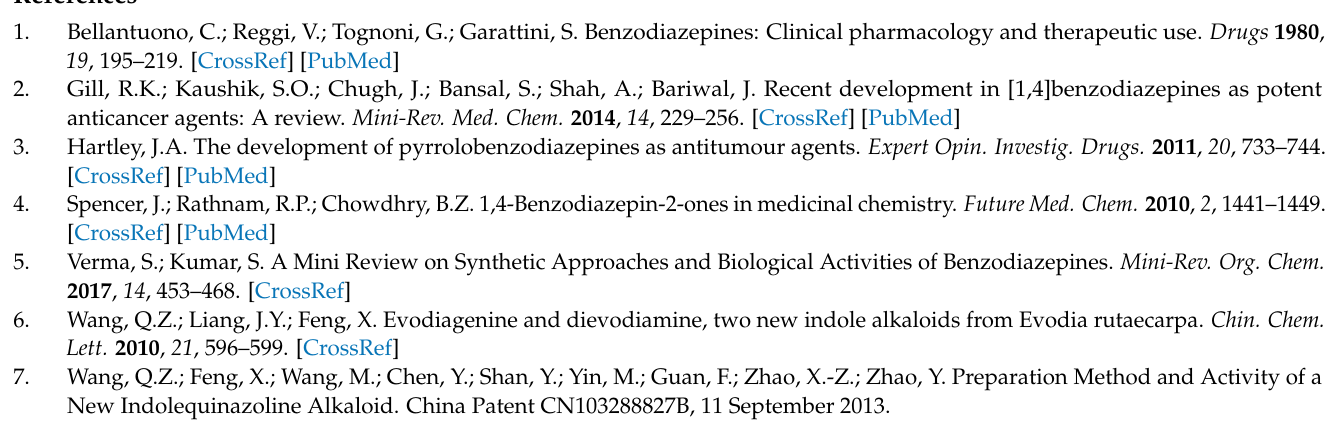
trum of 12 ; Figure S3. 1 H NMR spectrum of 10 ; Figure S4. 13 C NMR spectrum of 10 ; Figure S5. Dept135 NMR spectrum of 10 ; Figure S6. 1 H NMR spectrum of 11 ; Figure S7. 13 C NMR spectrum of 11 ; Figure S8. Dept135 NMR spectrum of 11 ; Figure S9. Confluence measured by IncuCyte live-cell imaging in